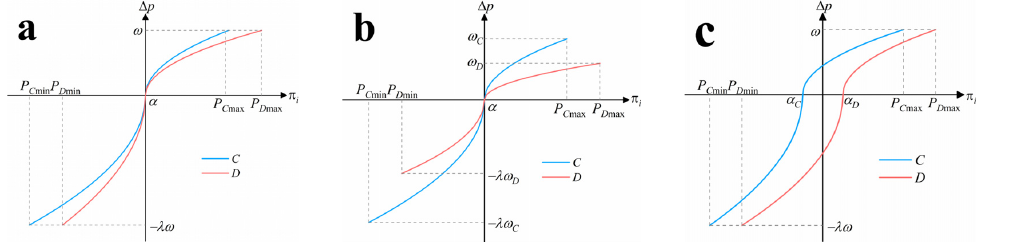
Figure 1. Schematic diagram of asymmetric micro − dynamics in an anonymous voluntary public goods game, where ( a ) 𝜔 (cid:3004) = 𝜔 (cid:3005) , 𝛼 (cid:3004) = 𝛼 (cid:3005) ; ( b ) 𝜔 (cid:3004) ≠ 𝜔 (cid:3005) , 𝛼 (cid:3004) = 𝛼 (cid:3005) ; and ( c ) 𝜔 (cid:3004) = 𝜔 (cid:3005) , 𝛼 (cid:3004) ≠ 𝛼 (cid:3005) .